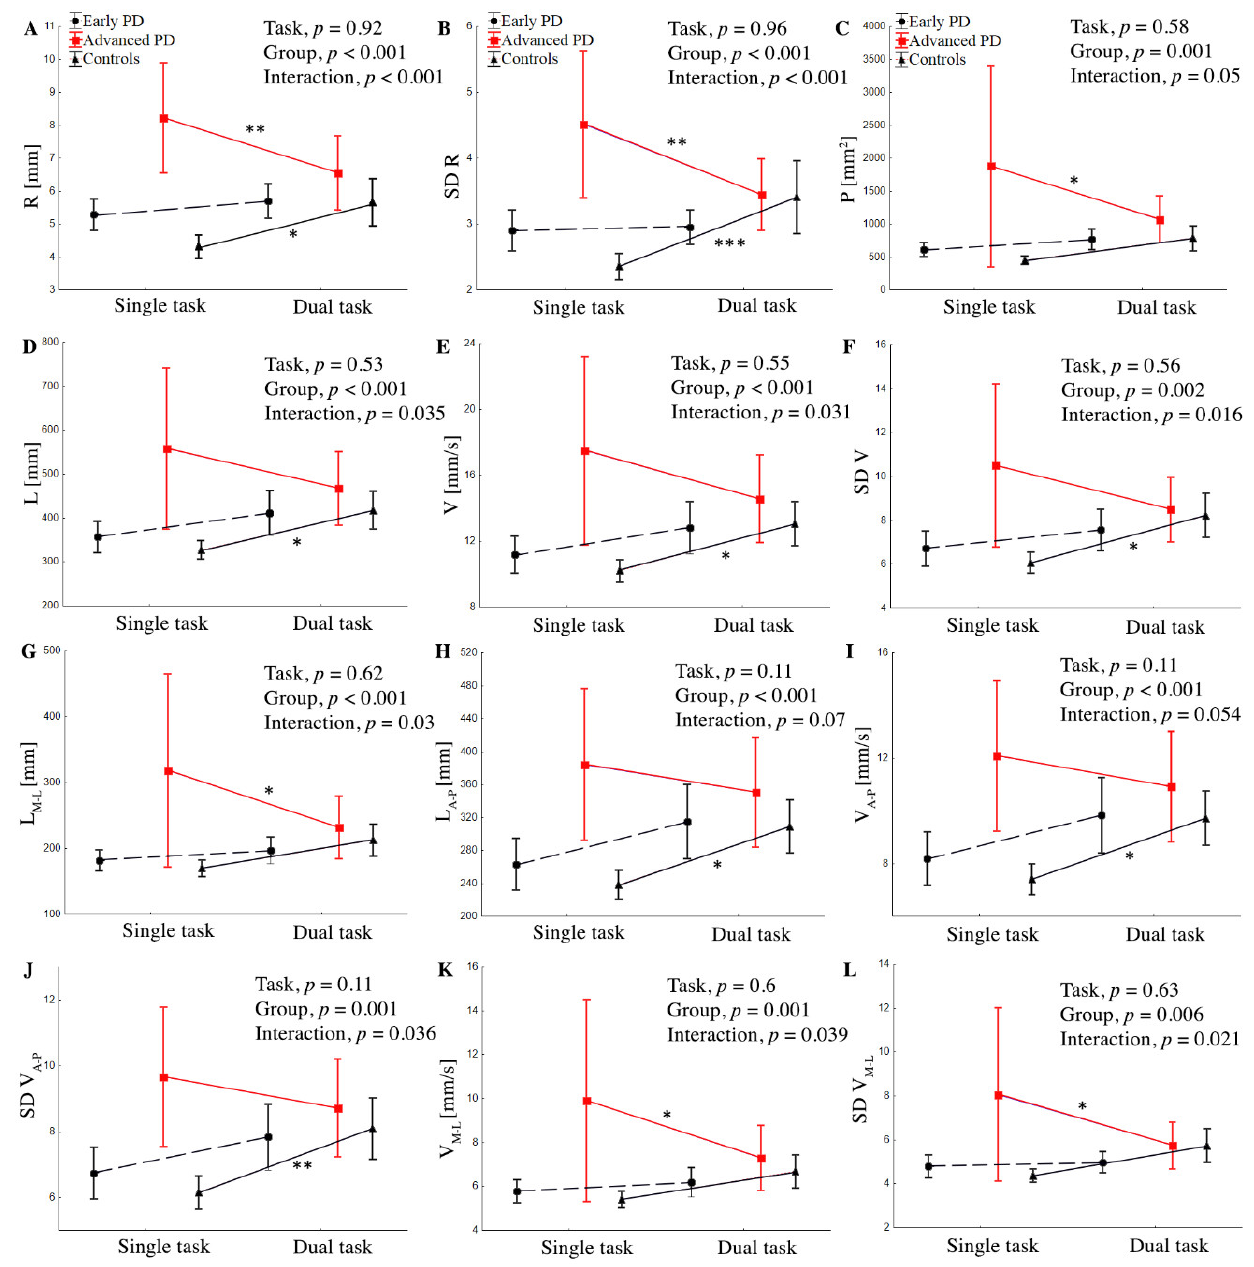
Figure 2. Group mean values (±SD) of R (A), SD R (B), P (C), L (D), V (E), SD V (F), L M-L (G), L A-P (H), V A-P , (I), SD V (J), V M-L (K) SD V M-L (L) during single and dual task and interaction between group and task for stabilographic parameters. ANOVA results for means’ difference between the control and PD groups. Statistically significant differences are indicated as * p < 0.05, ** p < 0.01, and *** p < 0.001.